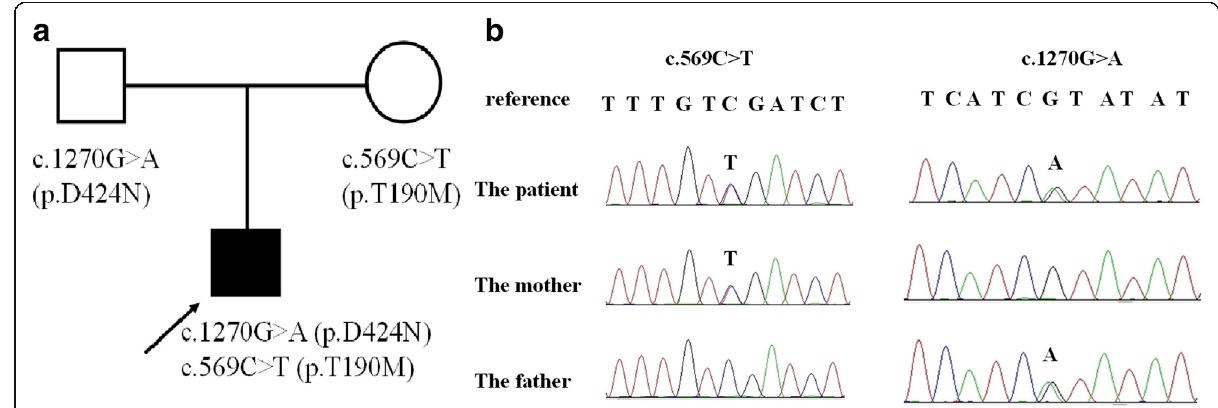
Fig. 1 The family pedigree showing the mutations detected in GLRA1 . a The pedigree of the family with hyperekplexia. The arrow indicates the proband; his parents have no signs of hyperekplexia. b The mutations detected in the family. The proband has both mutations, while the c.569C > T mutation was only detected in his mother and the c.1270G > A mutation was only detected in his